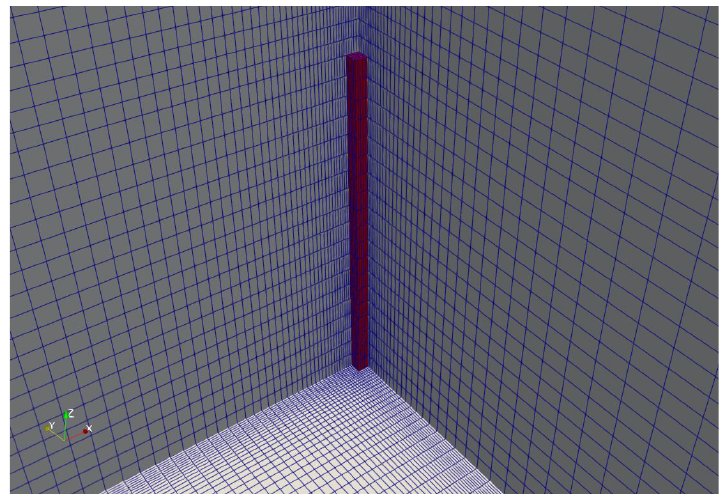
Figure 2. Mesh distribution around the square